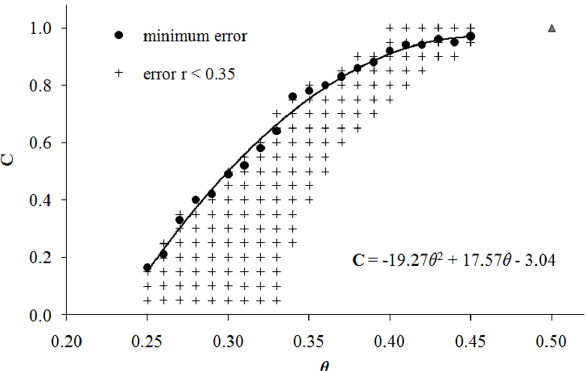
Fig. 3. Grid design for reverse routing test problem: the dark dots indicate optimal design; the stippled area +++ indicates grids satis- fying the modest shape accuracy criterion r < 0 . 3.